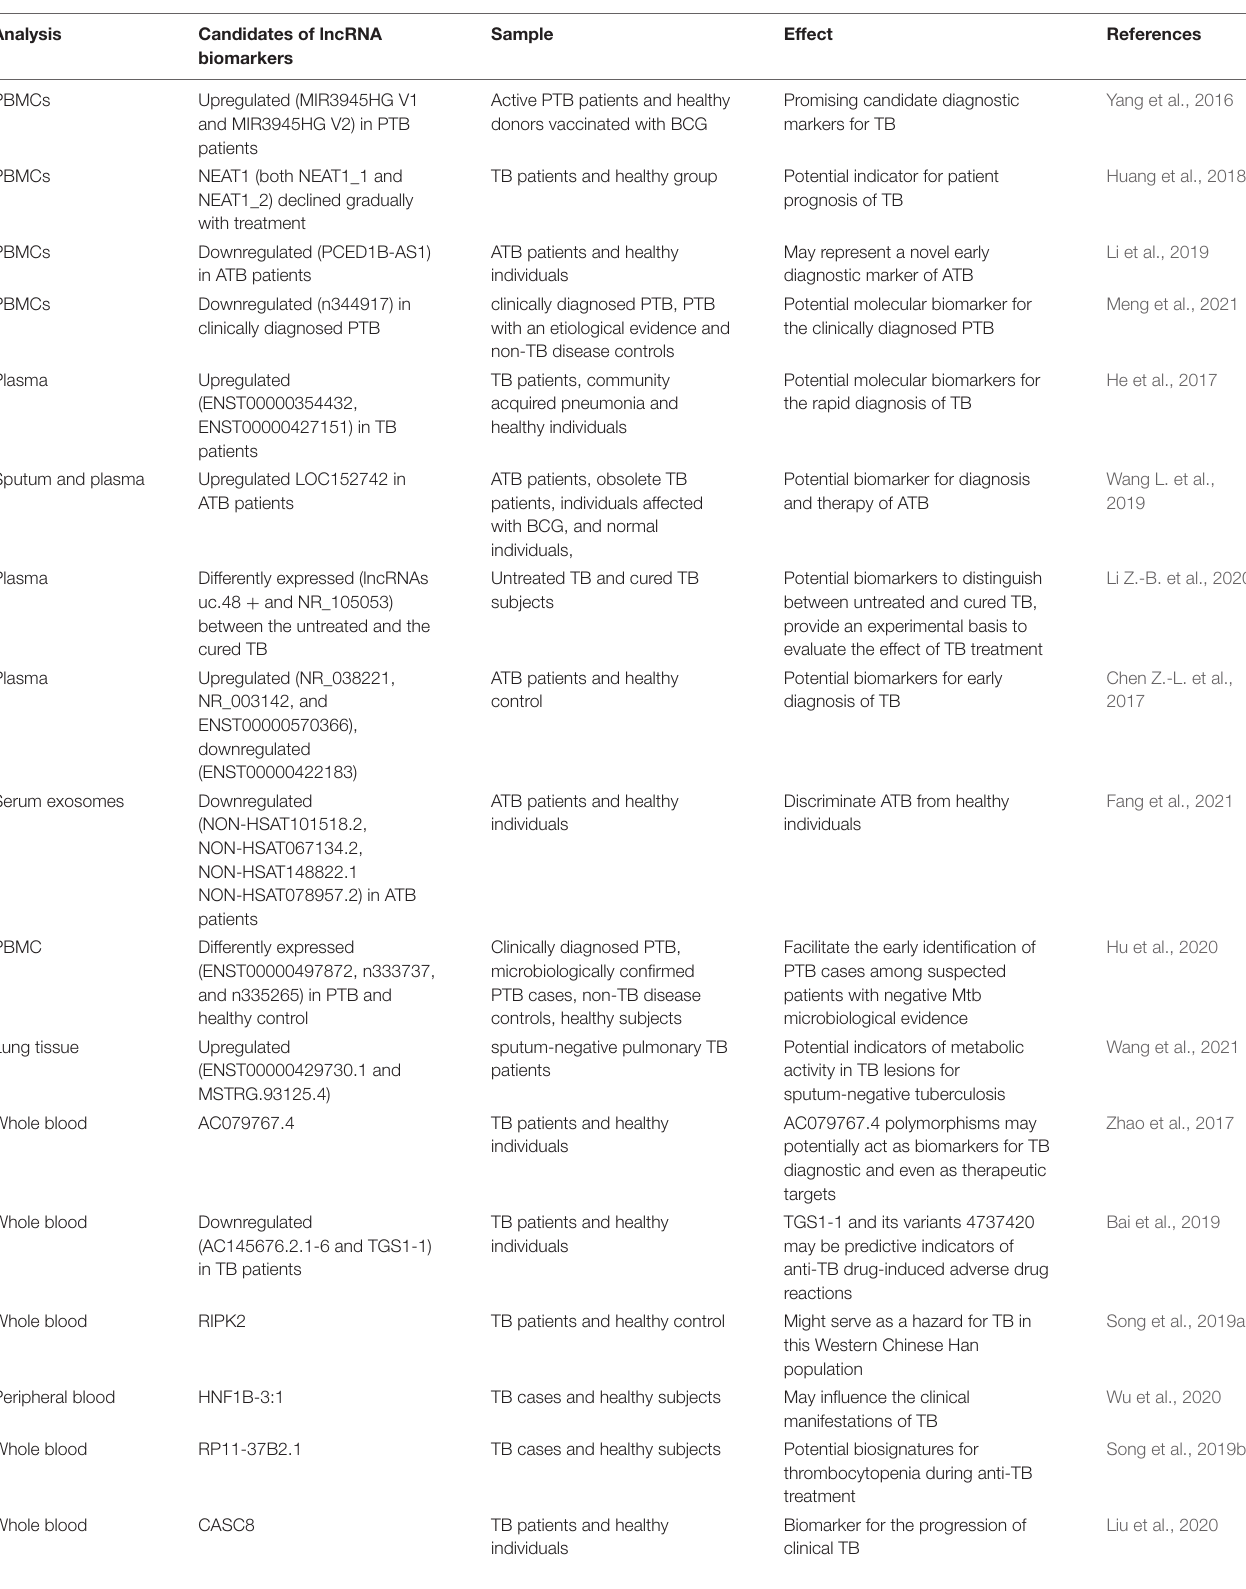
TABLE 2 | Overview of the candidate lncRNA biomarkers in